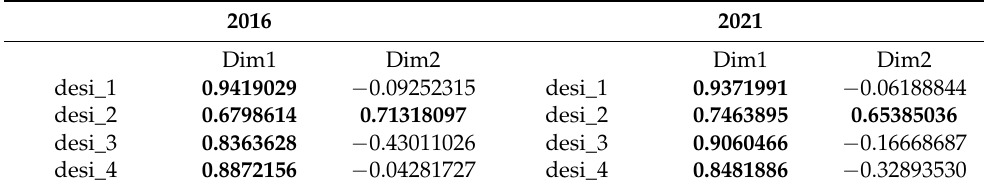
Table 6. Coordinates of